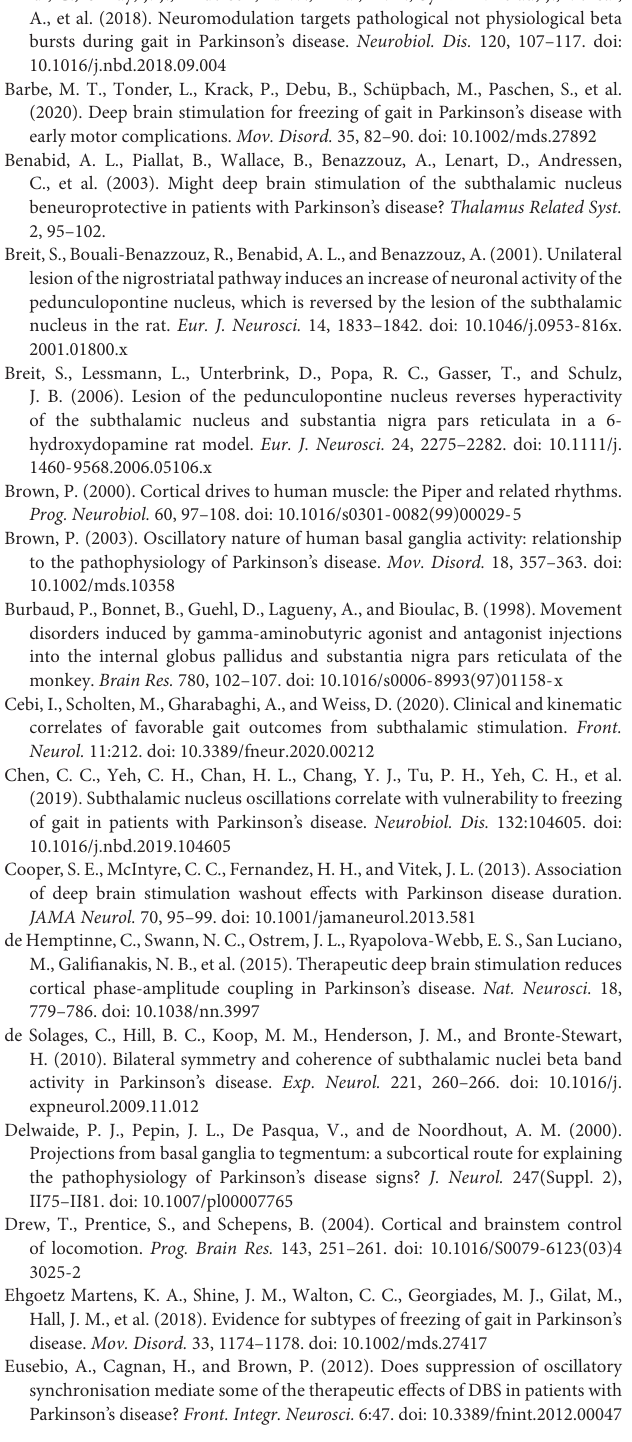
filtering of 1–200 Hz. PD patients in ‘StimOff‘ showed higher power of TA in the alpha and low-beta range (5.5–26 Hz; p = 0.0004) and a higher power in the GA muscle (6–45 Hz; p = 0.0004, cluster based permutation